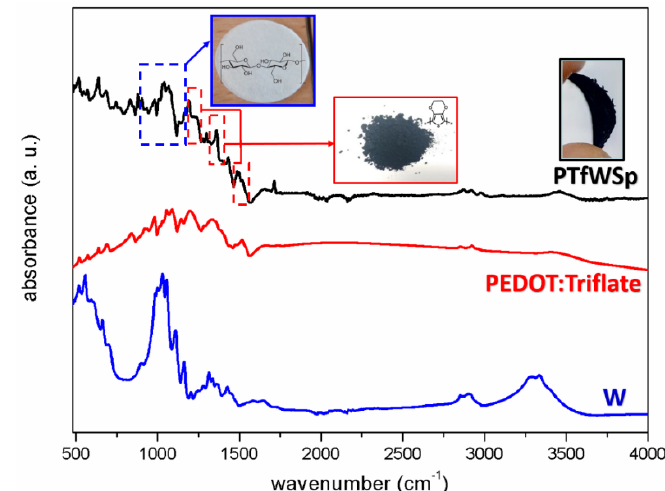
Figure 2. FTIR-ATR spectra of Whatman substrate (blue), PEDOT:Triflate (red), and PTfWSp composite material (black).